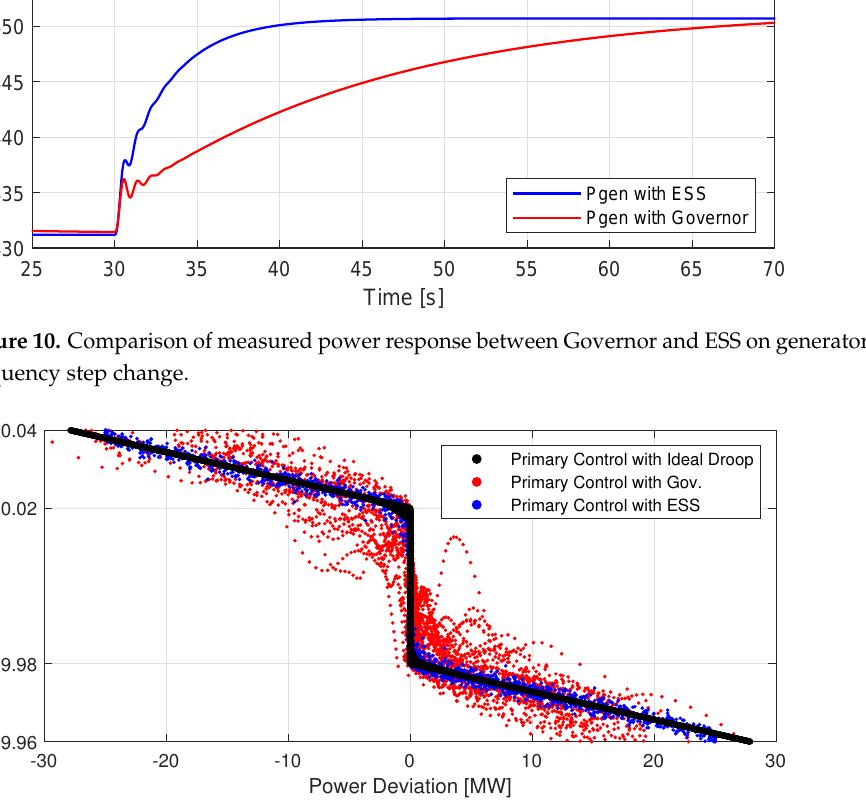
Figure 11. Frequency-Power graph indicating distribution of droop control between conventional governor and proposed governing